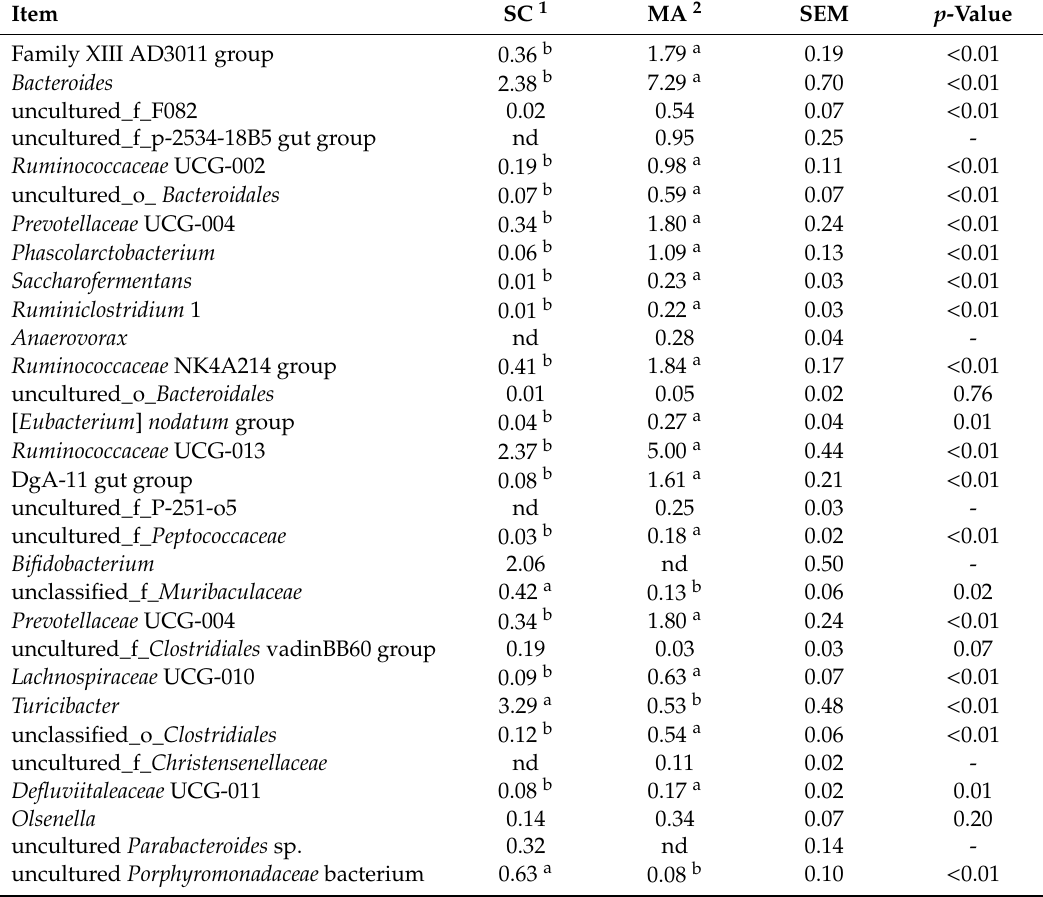
Table 4. Relative abundances of hindgut bacteria with the top 30 mean decrease in accuracy between the two